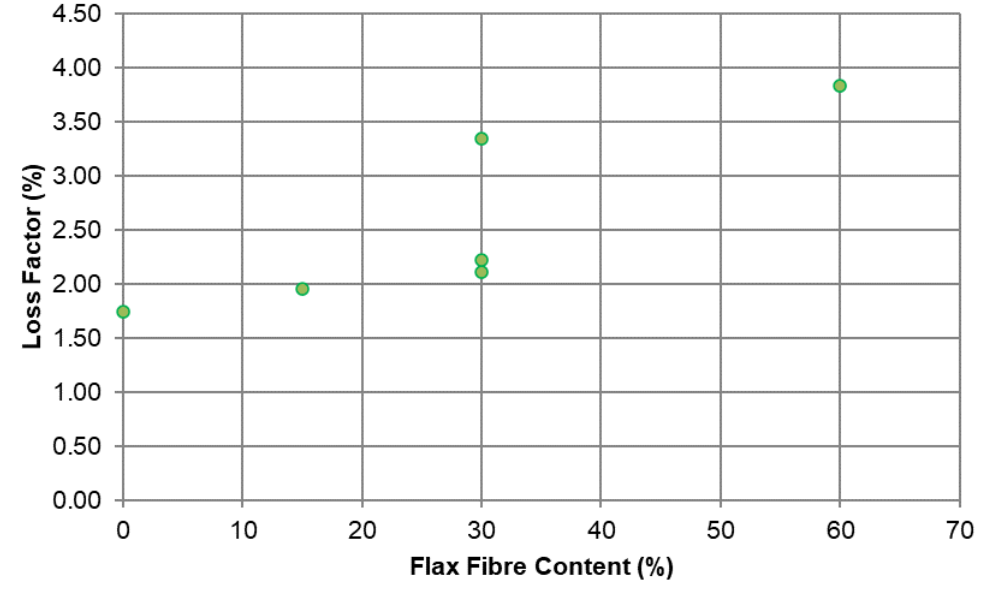
Figure 8. Loss factor versus flax fibre content for the composite specimens studied.